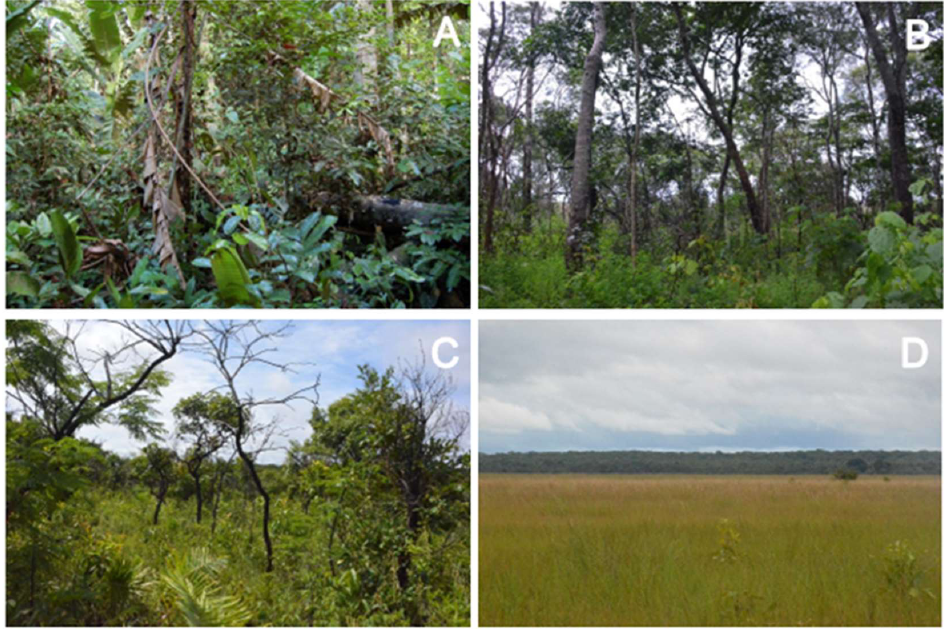
Figure 2. Ecoregions impacted by wildfires in Bolivia in the process of post-fire natural regeneration: ( A ) Southwest Amazonia, ( B ) Chiquitano Dry Forest, ( C ) Cerrado, and ( D ) Seasonally Flooded Savanna. Photos: Oswaldo Maillard.